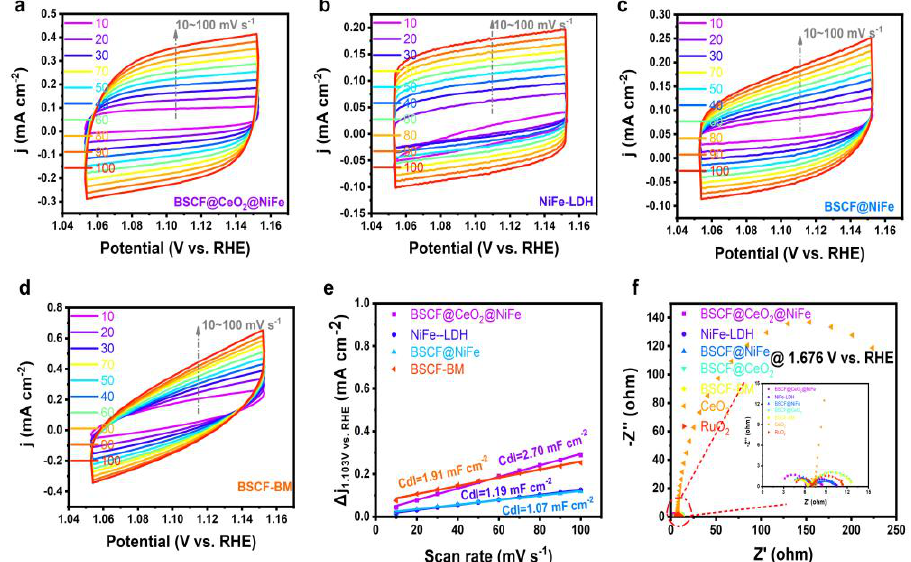
Figure 4. CV curves of BSCF@CeO 2 @NiFe ( a ), NiFe-LDH ( b ), BSCF@NiFe ( c ), and BSCF ( d ) catalysts at 0.15~0.25 V (vs. Hg/HgO) with scan rates of 10, 20, 30, 40, 50, 60, 70, 80, 90, and 100 mV s −1 . Corresponding C dl values ( e ) and EIS Nyquist plots ( f ) of BSCF@CeO 2 @NiFe, BSCF@NiFe, NiFe-LDH, BSCF@CeO 2 , BSCF, CeO 2 , and RuO 2 . The insert of ( f ) is the EIS plots in a smaller range.